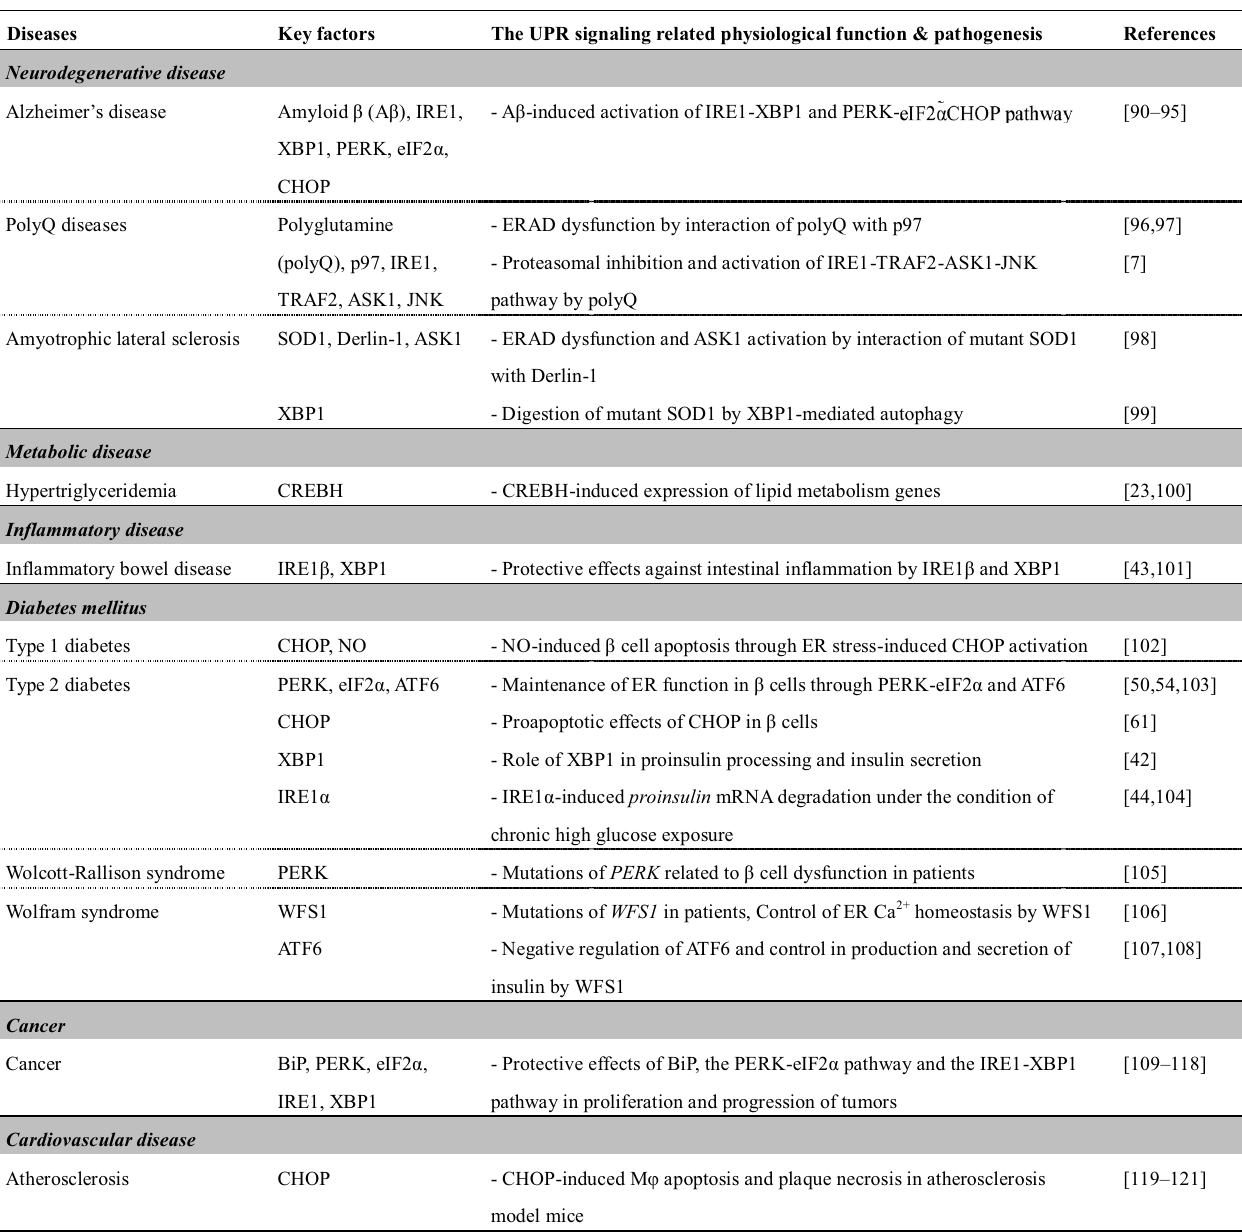
Table 1. ER stress-related molecules associated with